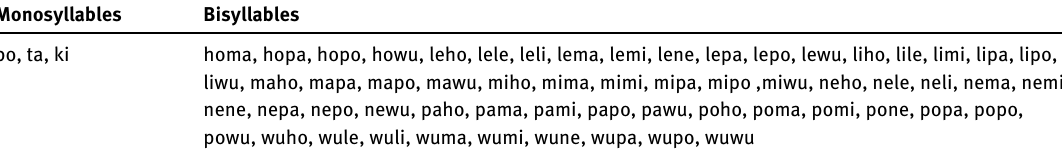
Figure 2 : Example training (left) and testing (right) screens. In training, participants are shown an image of the noun, the artificial language, and a gloss for the verb and noun. In testing, their task is only to recall which affix goes with the noun being presented. All syllables used in every language had a Consonant-Vowel structure. The monosyllables were used for the three noun-class markers, and the words for the verb and nouns for each language were chosen randomly from the set of bisyllabic forms. See Table 1 for a complete list of the possible monosyllabic and bisyllabic forms used in the experiment. Table 1 : The set of monosyllables and bisyllables used in the experiment Monosyllables